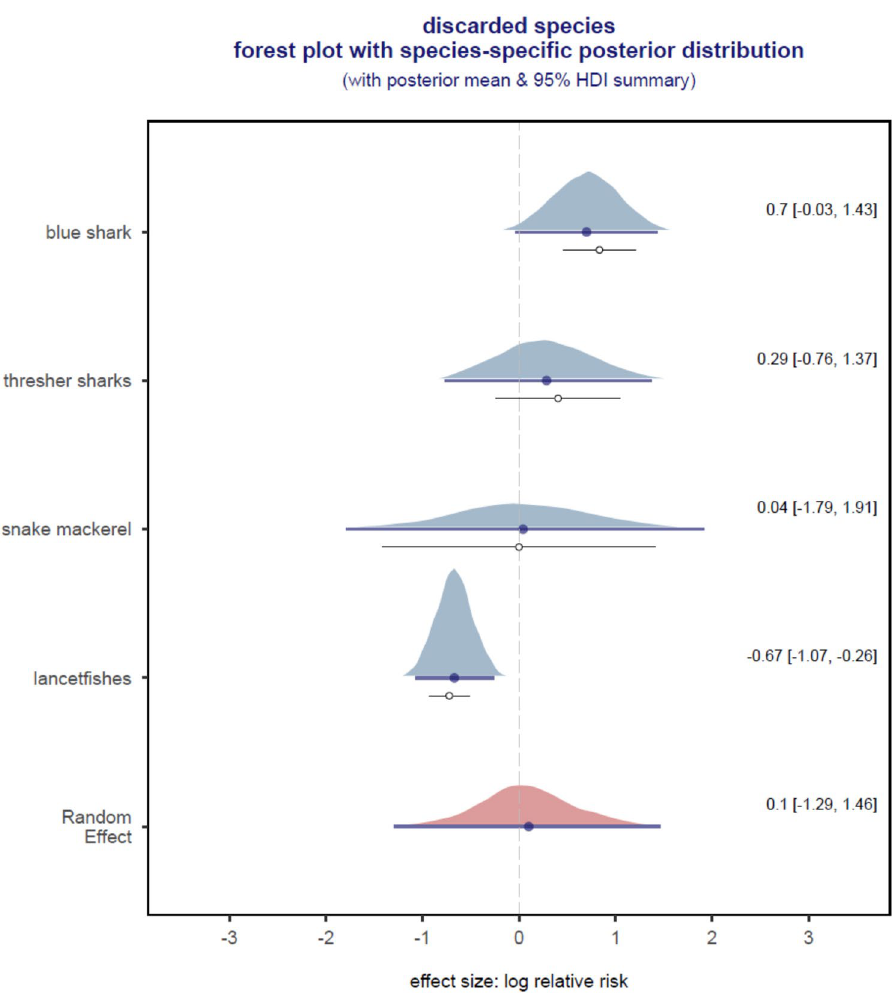
Figure 4. Model-predicted log relative risk ratio derived for 4 species-specific effect sizes for discarded species. Shrinkage estimates were derived using a precision weighted Bayesian random-effects meta-analytic model with Gaussian likelihood. Polygon = density of the posterior draws (the effective sample size = 10,000) and the horizontal line underneath each polygon = 95% highest posterior density interval (HDI) of the posterior draws, solid dot = mean of the posterior draws shrunk towards the Random Effect, which is the overall expected log relative risk ratio for all 4 species (right-side labels = the posterior mean and HDI summaries). Below the density polygon is an open dot = observed effect size and thin horizontal line = observed effect size ± 1 standard deviation derived using the metafor::escalc() function . The difference between solid and open dots reflects the degree of shrinkage that is dependent on sample